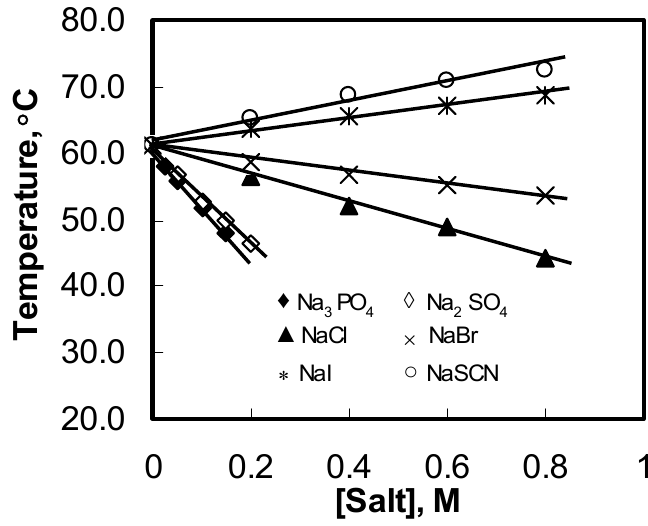
Figure 2. Peak temperature (T) variations for aqueous solutions of 1 wt% HPMC as a function of the added salts concentration during the heating